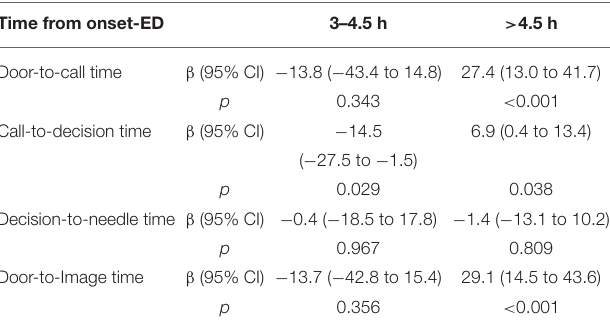
TABLE 4 | Estimated effects on workflow times (from linear regression) of symptom-onset to presentation time after the protocol was changed to include patients presenting up to 24-h after